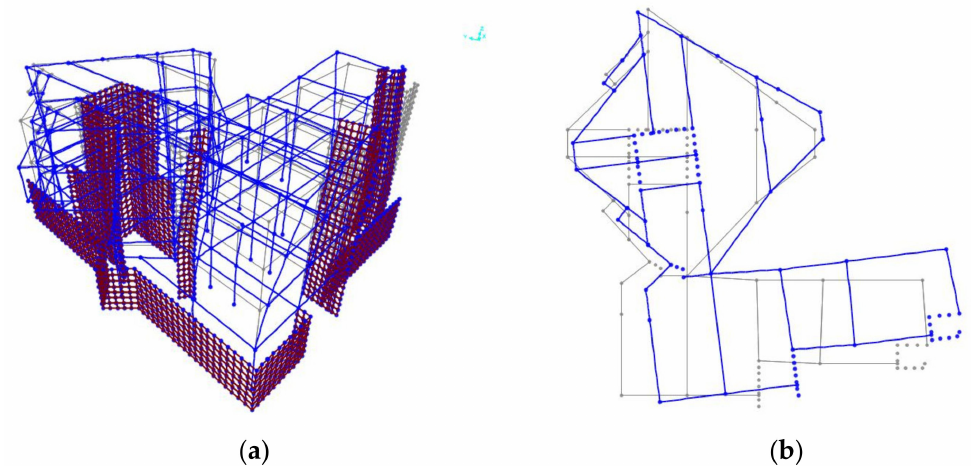
Figure 16. First mode is a torsional-bending mode along x axis with frequency equal to 4.94 Hz (in grey the un-deformed configuration and in blue the mode shape): ( a ) 3D view; ( b ) plan